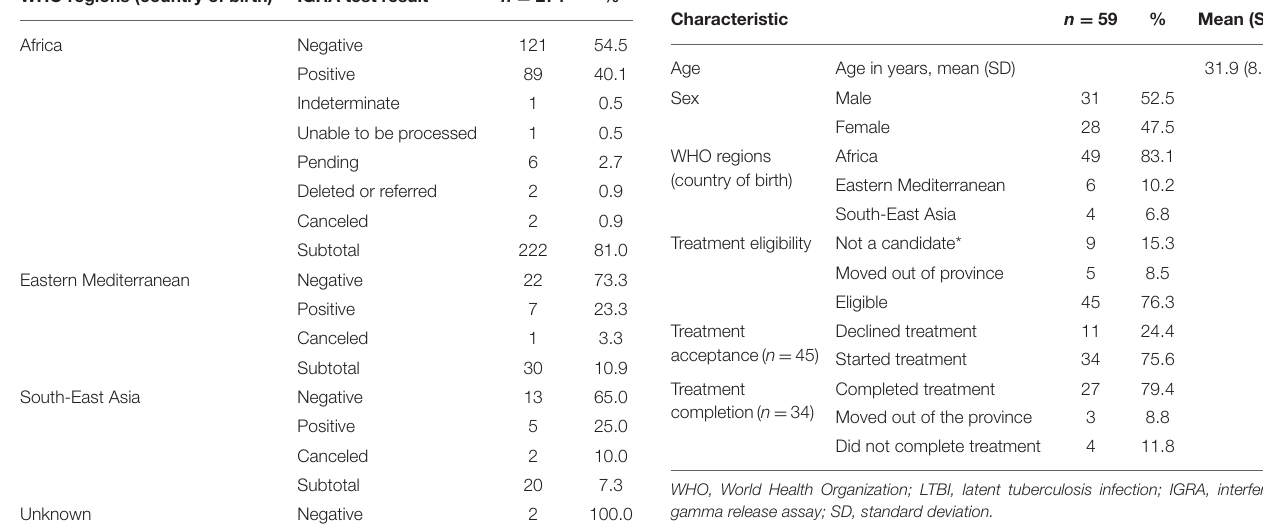
TABLE 2 | IGRA test results from adult refugees at BridgeCare Clinic, by WHO regions according to the country of birth, January 2015–October 2016. WHO regions (country of birth) IGRA test result n = 274 Africa